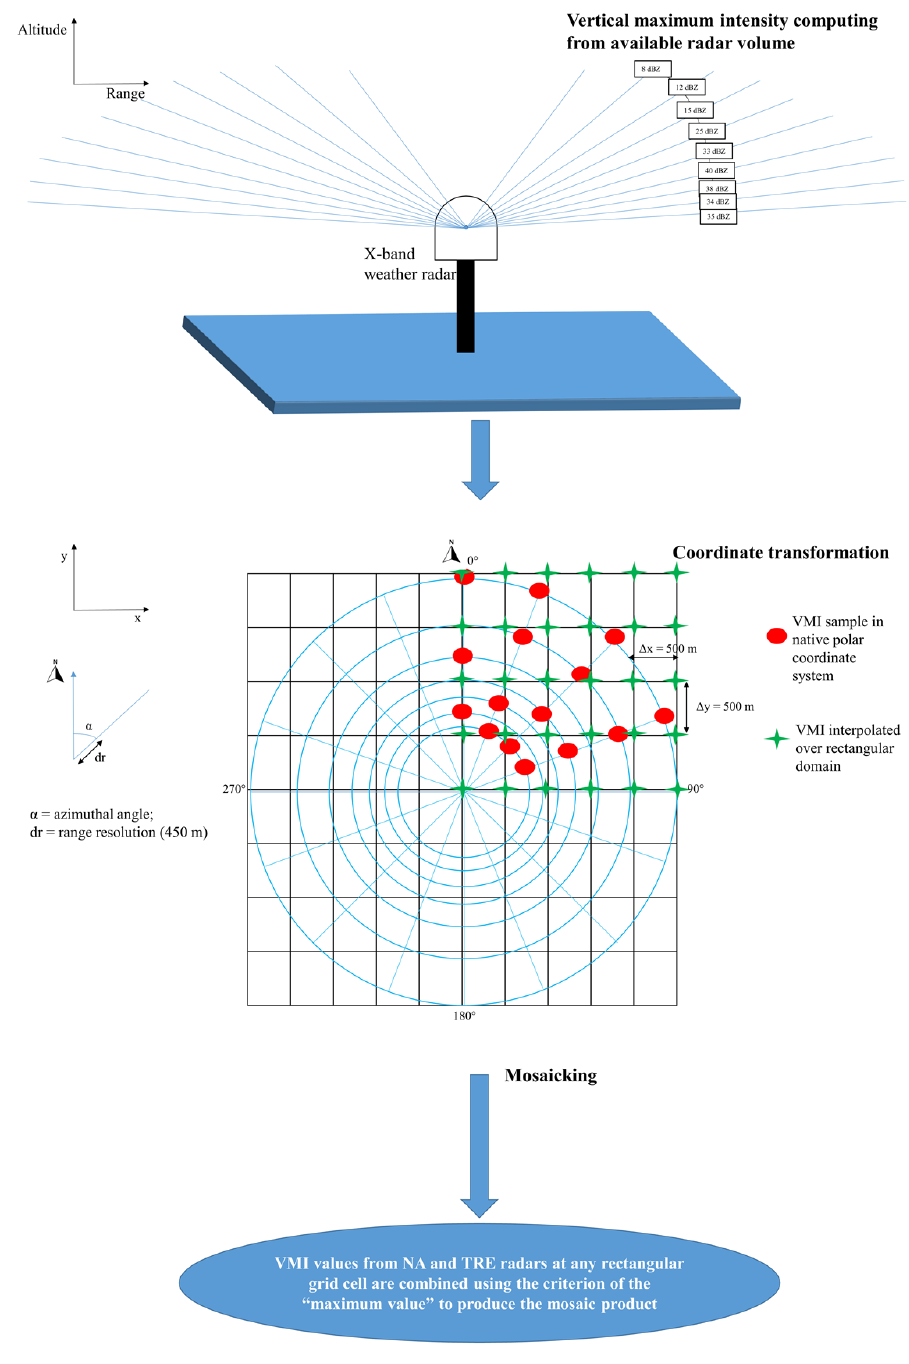
Figure 3. Schematic diagram of X-band weather radar processing for mosaicking generation. The process starts with the computing, for both the Naples and Trevico radar, of the Vertical Maximum Intensity product ( upper panel). Subsequently, the VMI products, originally available in the native polar coordinate system, are remapped onto a cartesian grid, with a resolution of 500 × 500 m ( middle panel). Finally, the composite product is obtained using the “maximum value” criterion ( bottom panel).